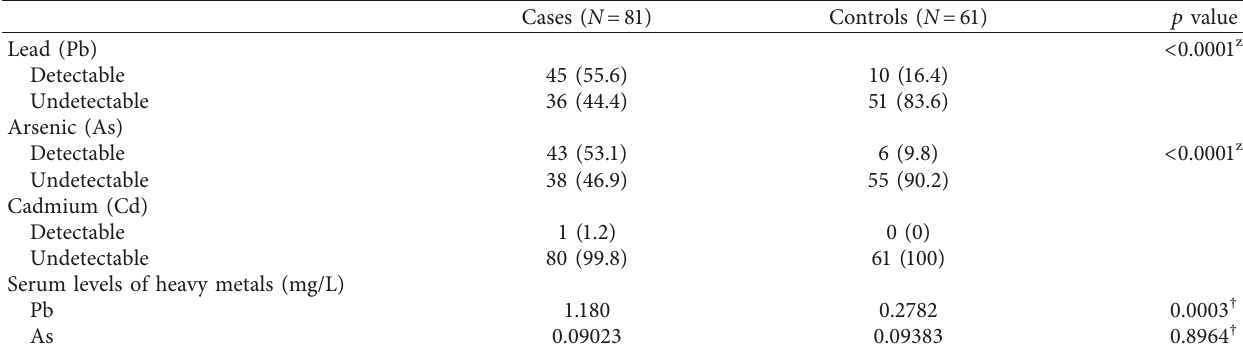
Table 4: Heavy metal levels in the serum of participants.